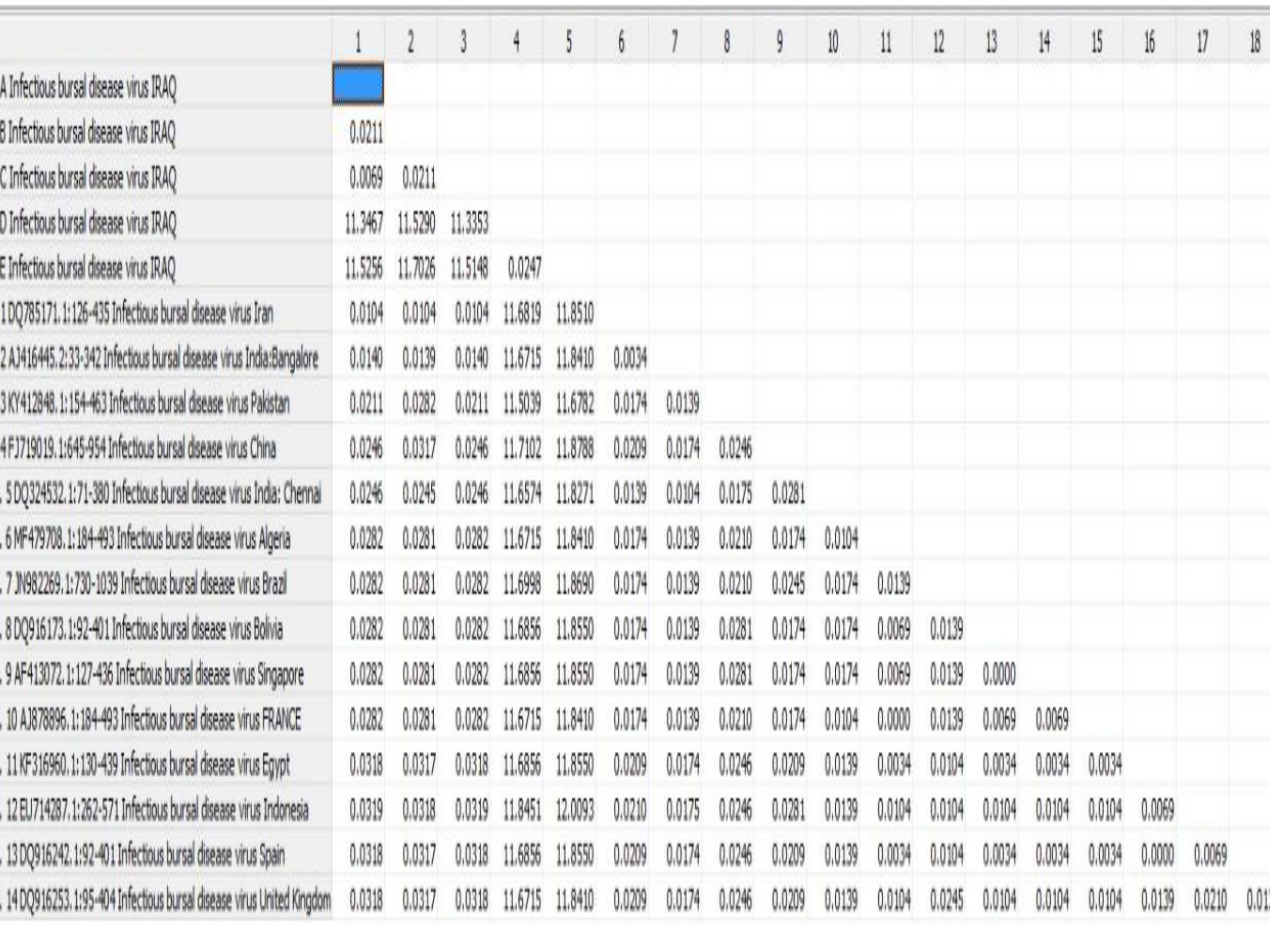
Table 4. Referential IBDV strain were used in this study for phylogenetic analysis of VP2